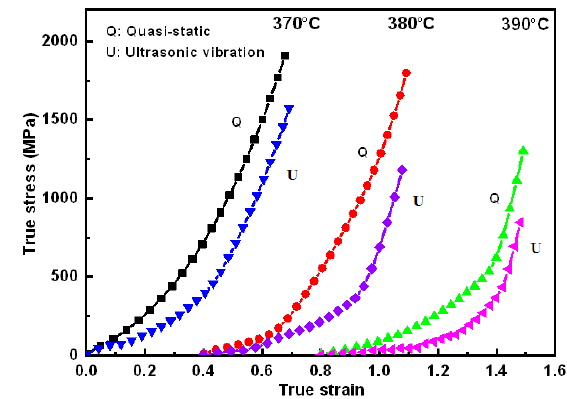
Figure 6. True stress–strain curves at different supercooled liquid temperatures.